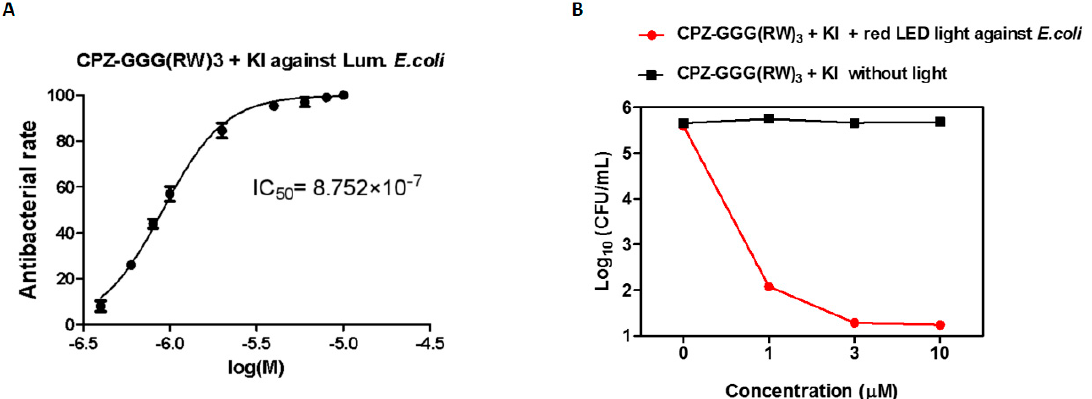
Figure 5. Phototoxicity of CPZ-GGG(RW)3 and potassium iodide against the luminescent E. coli strain under red LED light illumination (22.5 J/cm 2 ) measured by luminescent signals ( A ). Phototoxicity of CPZ-GGG(RW)3 and potassium iodide under illumination (22.5 J/cm 2 ) by red LED light against Gram-negative E. coli measured by colony forming units ( B ).